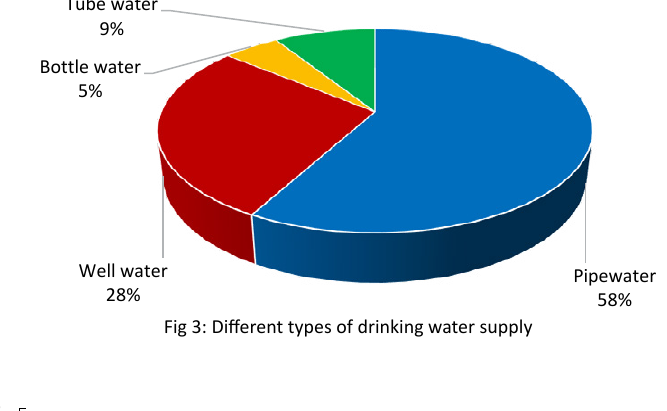
Fig 3: Different types of drinking water supply